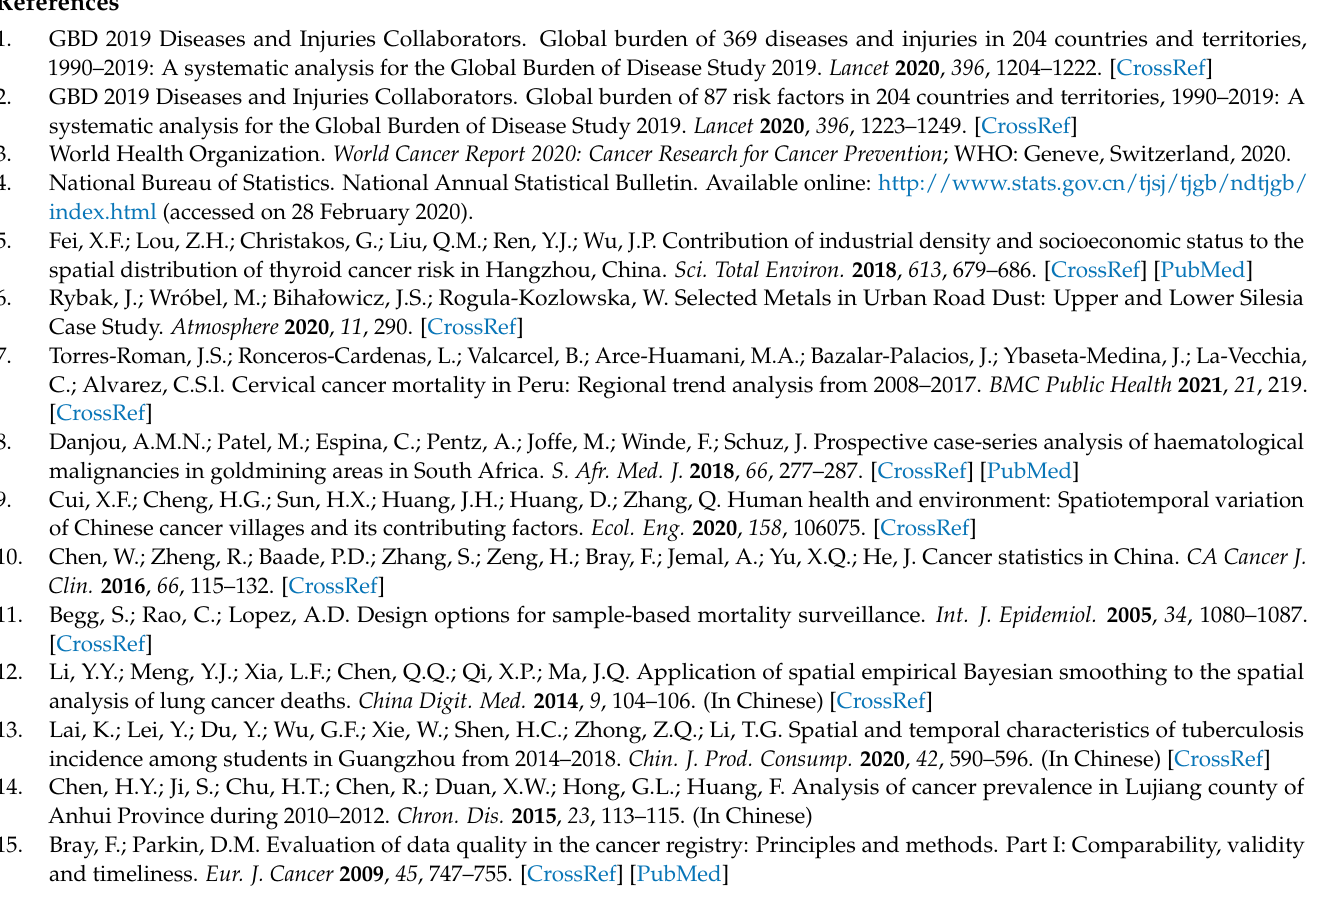
Table S3: Ellipse parameters of standard deviation of digestive tract cancer incidence in Lujiang County from 2012 to 2017. Table S4: GM(1,1) model test results. Table S5: Ellipse parameters of standard deviation of digestive tract cancer incidence in Lujiang County from 2018 to 2025. Figure S1: Research framework. Figure S2: Number of industrial enterprises above designated size (annual operating income > 20